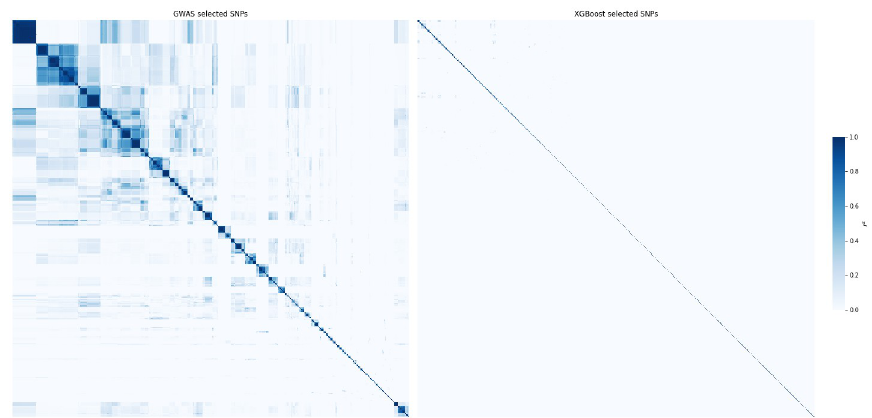
Fig 6. Clustered correlation heatmaps between top 1K SNPs selected by GWAS (left) and XGBoost (right) for asthma with 20 covariates, sex and PCA. GWAS selects SNPs by lowest p-value, XGBoost selects SNPs by highest importance score. The SNP sets in the left and right subfigure are different; the SNPs are sorted to produce clusters on the heatmaps. The color shows the squared correlation coefficient r 2 between SNPs, estimated by plink 1.9. The average r 2 is 0.0593 for GWAS and 0.0063 for XGBoost.